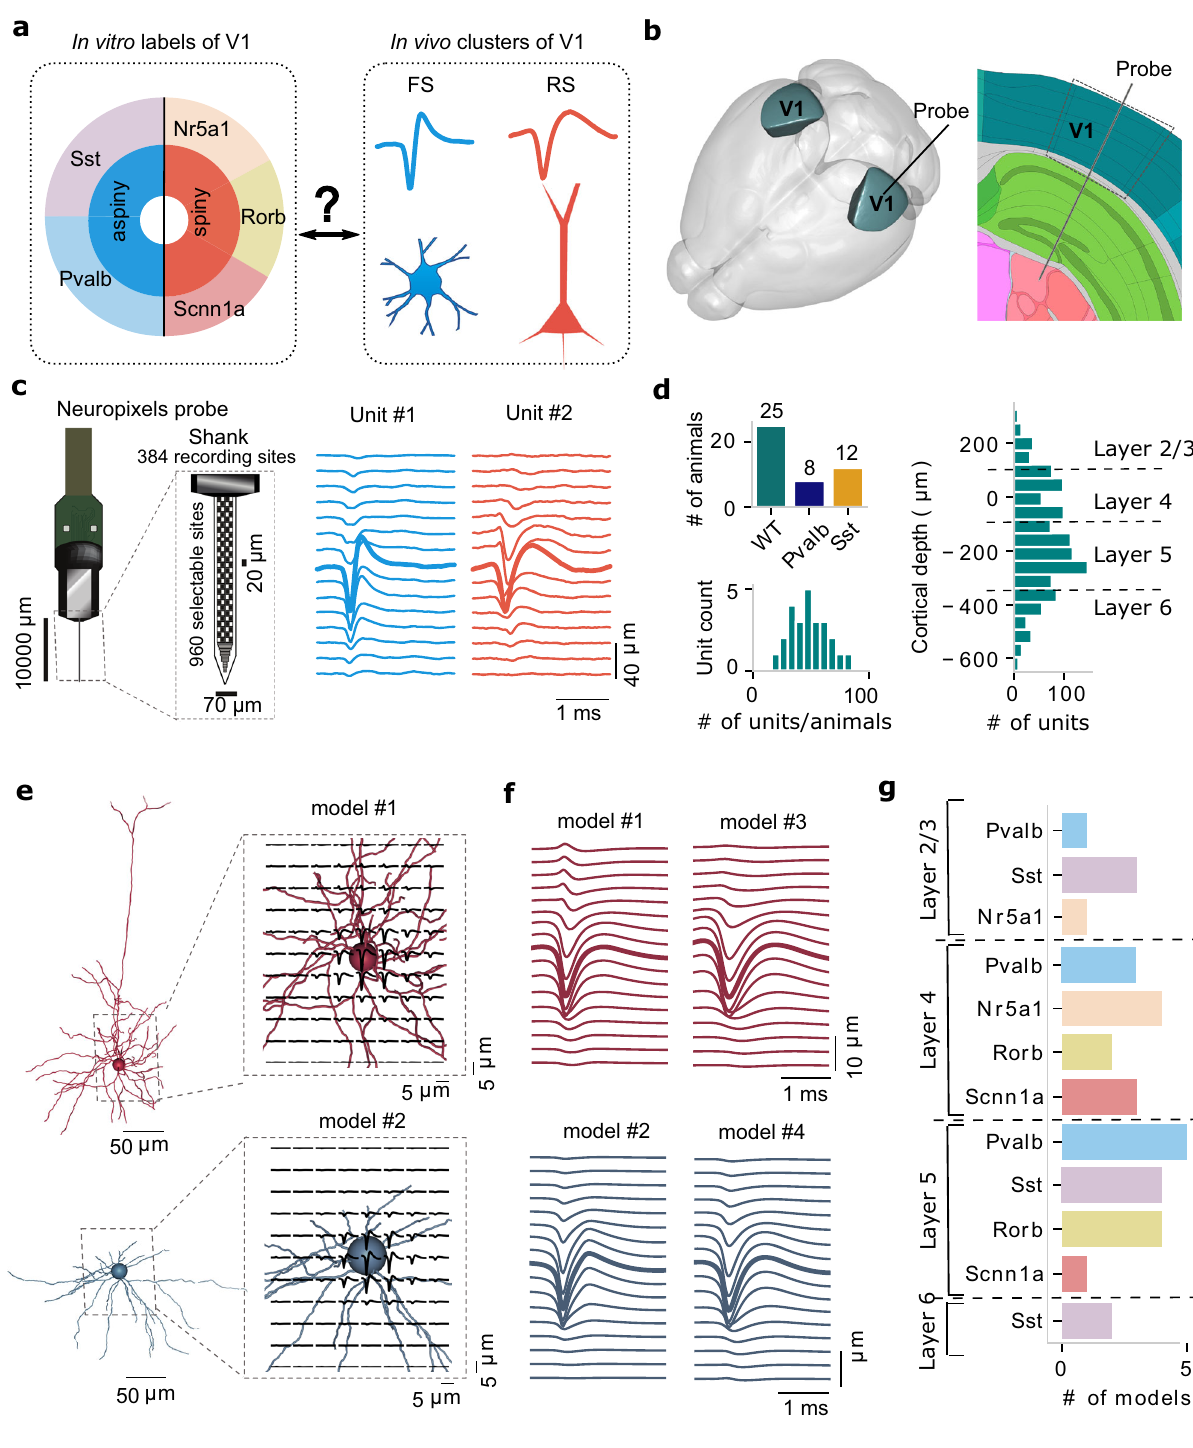
Spatial features reveal six distinct sub-clusters in mouse V1: 3 RS separately estimated via linear regression (Fig. 2b, right, red lines). We and 3 FS de fi ne apropagation symmetry index, the ratioof 1/ V below and 1/ V above , Multi-channel EAP waveforms introduce an additional dimension, with a larger symmetry index indicating a more asymmetric propaga- space, into the analysis. We accounted for the EAP amplitude and the tion, for example, due to the presence of apical dendrites in excitatory EAP propagation with respect to time (Fig. 2b, right) as a function of pyramidal neurons 32 . Looking at the multi-channel EAP features of FS vs. RS, RS generally exhibits a more asymmetric EAP propagation recording distance to the largest EAP location, assumed to be closest below vs. above the putative soma location than FS, Fig. 2c, d; Fig. S3c, to the soma/axon initial segment 25 . For the multi-channel analysis (Fig. 2b, middle), we calculate two additional spatial EAP features d, middle). We conclude that one-channel clusters RS and FS do not (Fig. 2b, right): the inverse of the EAP propagation velocity below (1/ only separate via TPW but, in fact, are also distinct in how their spikes V V V 22 . 1/ V propagate along the extracellular below ) and above (1/ above ) the soma below and 1/ above are